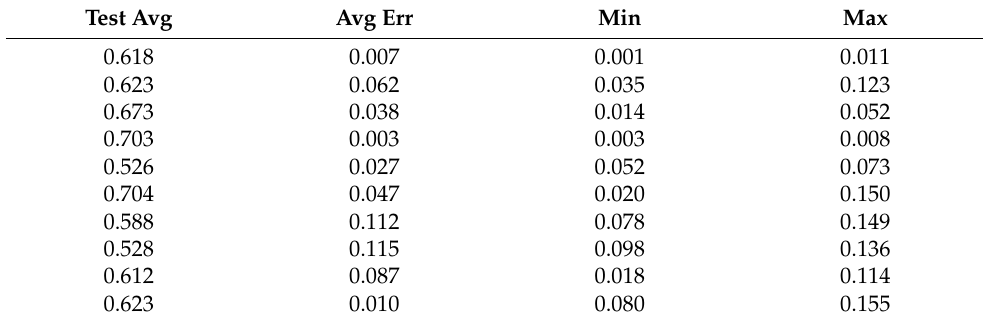
Table A130. Set 2, trials 31–40 data (actual PR value).